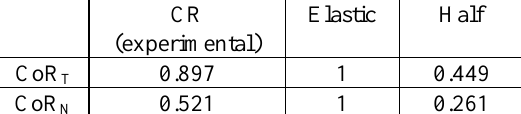
Table 1. Experimental CoR values for granitic sand powder and referential CoR for simulations use .